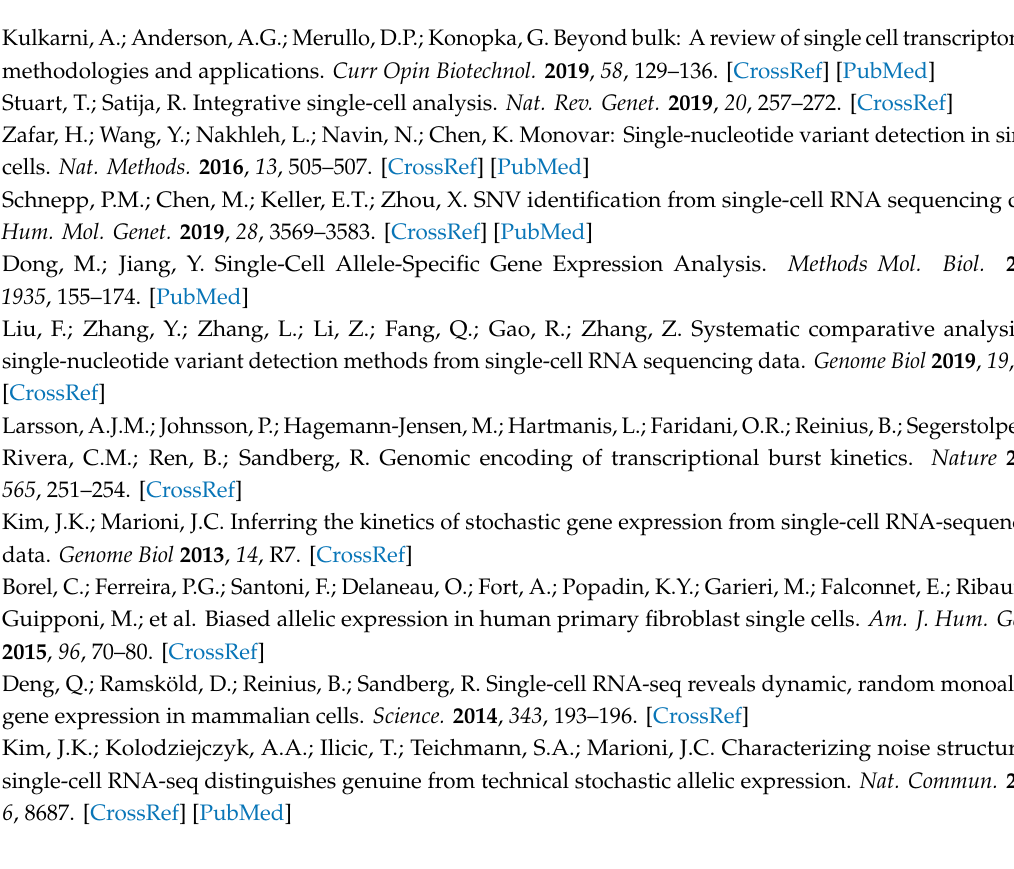
Supplementary Materials: The following are available online at http: // www.mdpi.com / 2073-4425 / 11 / 3 / 240 / s1: Figure S1: Mean and median VAF RNA ; Figure S2: VAF RNA distributions and cell counts; Table S1: SNV loci minR10 10cells; Table S2: SNV loci minR5 10cells; Table S3: SNV loci minR10